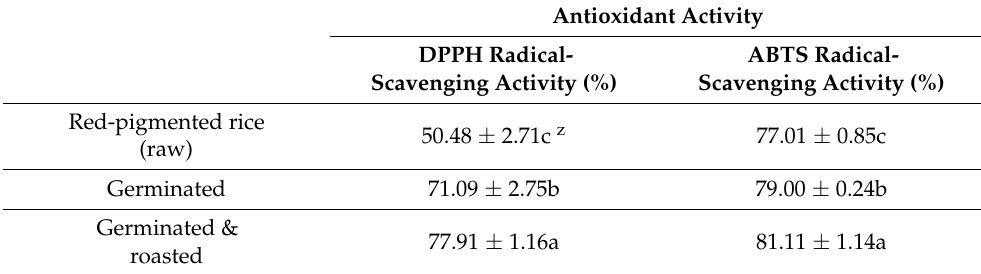
Table 4. Effects of germination and roasting on in vitro antioxidant activity of red-pigmented